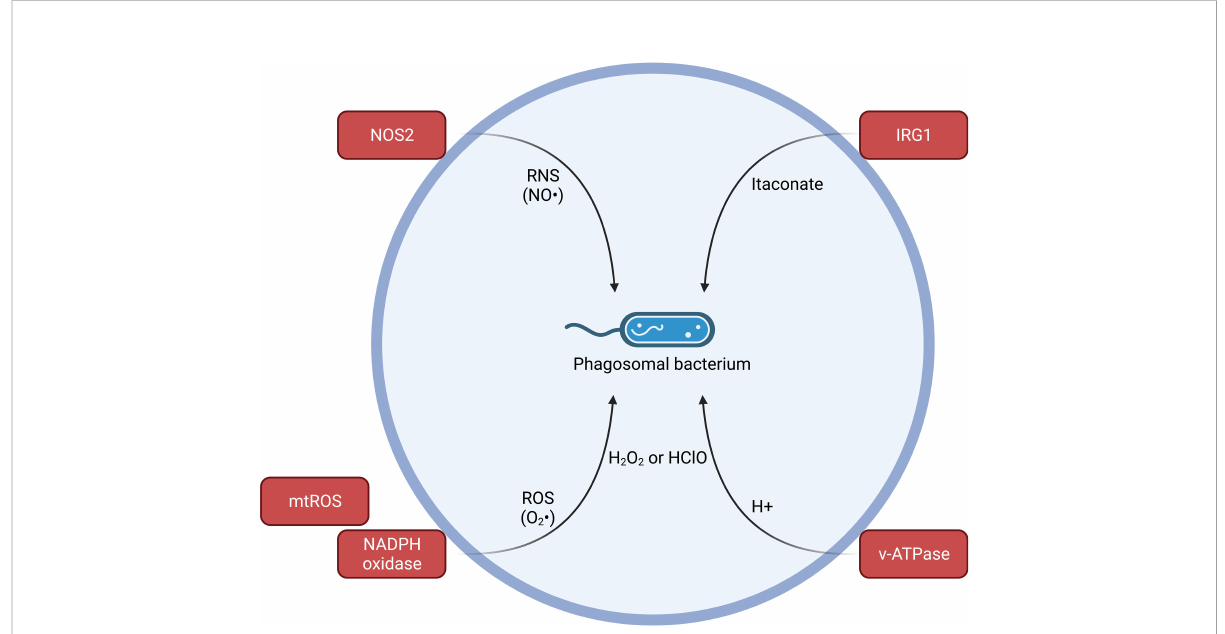
FIGURE 3 Host-adapted delivery of potentially toxic metabolites for control of intracellular pathogens. Sensation of PAMPs, cytokines, and IFNs can promote cell-intrinsic immune responses such as generation of antimicrobial metabolites. Upregulation of NOS2 can produce NO radicals from the amino acid Arginine. TLR driven mitochondrial ROS (mtROS) or phagocytosis- and BAI1-induced NADPH oxidase production of ROS. ROS can cooperate with low pH environment created by pumping H+ ions into the vesicle lumen via the action of v-ATPase to form hydrogen peroxide and hypochlorous acid. Accumulation of TCA intermediates based on break in the TCA cycle in activated macrophages allows for Irg1 production of anti-microbial itaconate that can be delivered to a pathogen-containing phagosome via